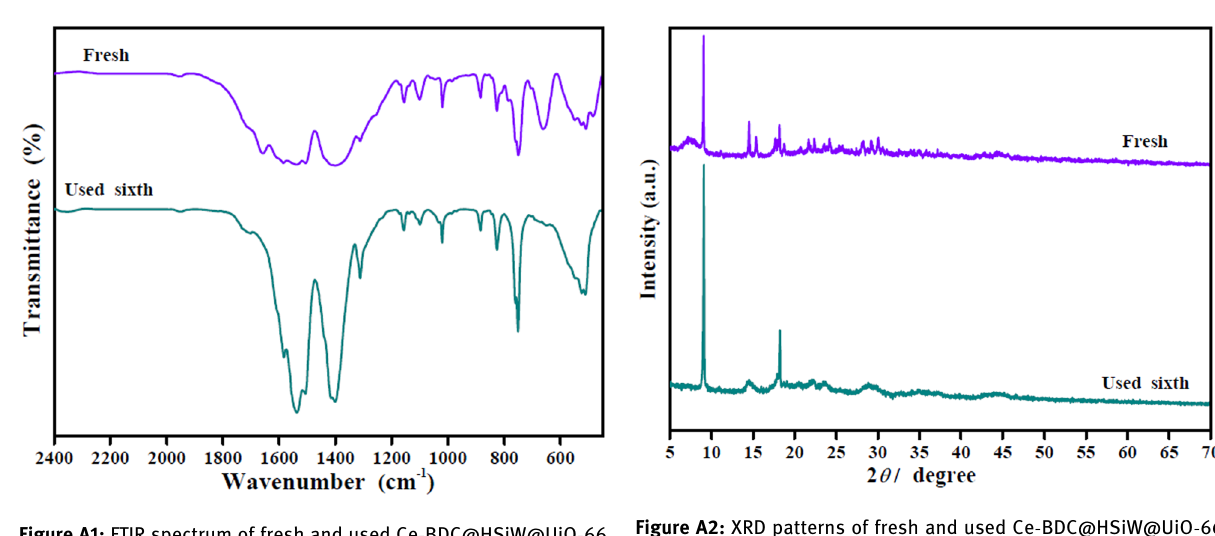
Figure A1: FTIR spectrum of fresh and used Ce - BDC@HSiW@UiO - 66 catalysts.